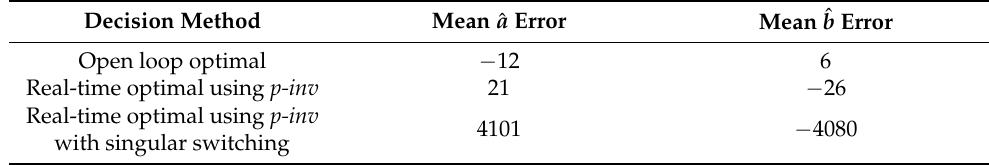
Table 6. Comparison of real-time optimal decision methods using p-inv matrix inversion.